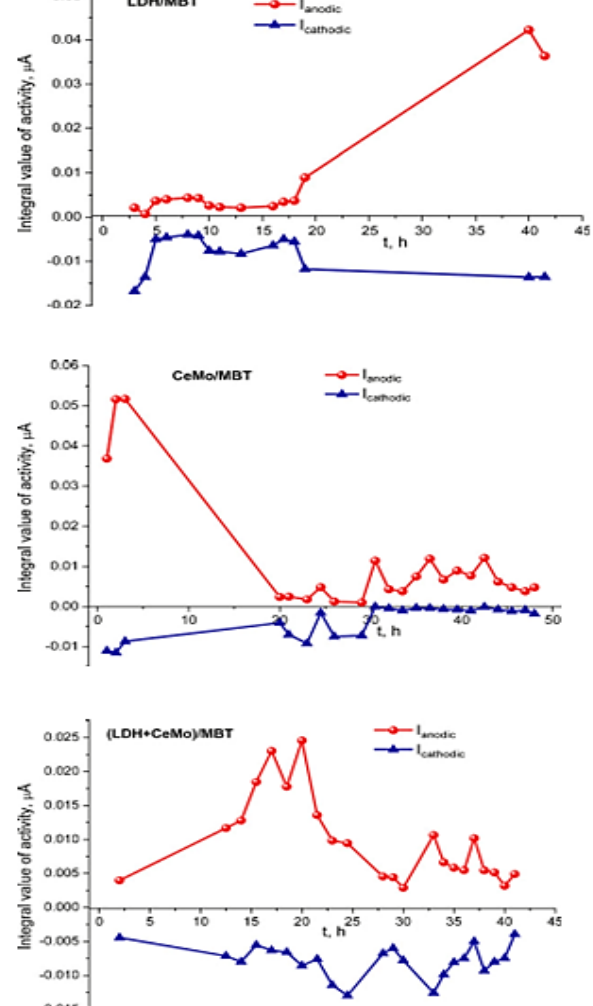
Figure 22. I anodic – I cathodic current of the LDH(MBT), CeMo(LDH), and LDH(MBT) + CeMo(LDH) systems.